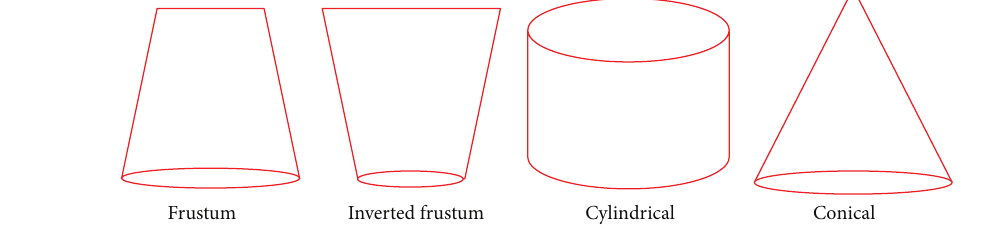
Figure 4: Four types of the receiver.